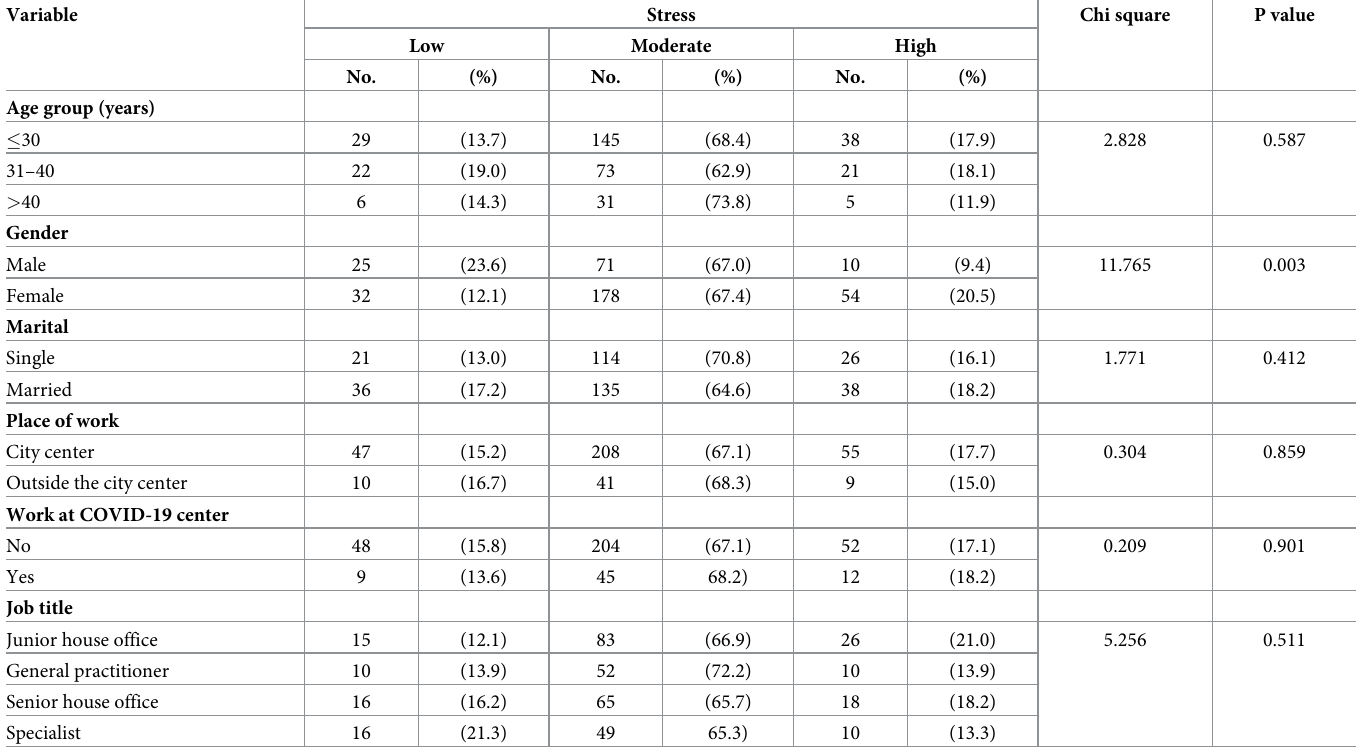
Table 3. Prevalence of different degrees of stress according to the demographic and professional characteristics of the participants.